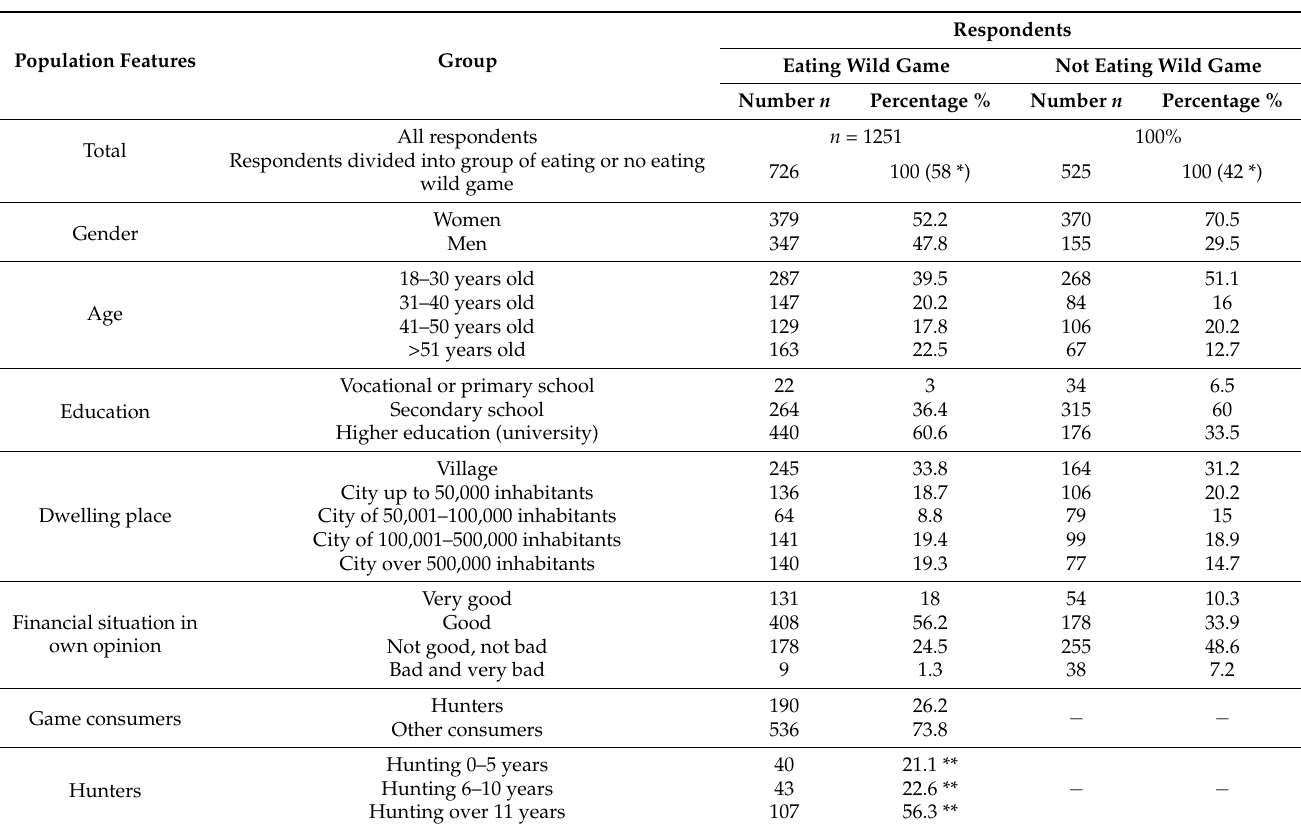
Table 1. Characteristics of the surveyed sample of